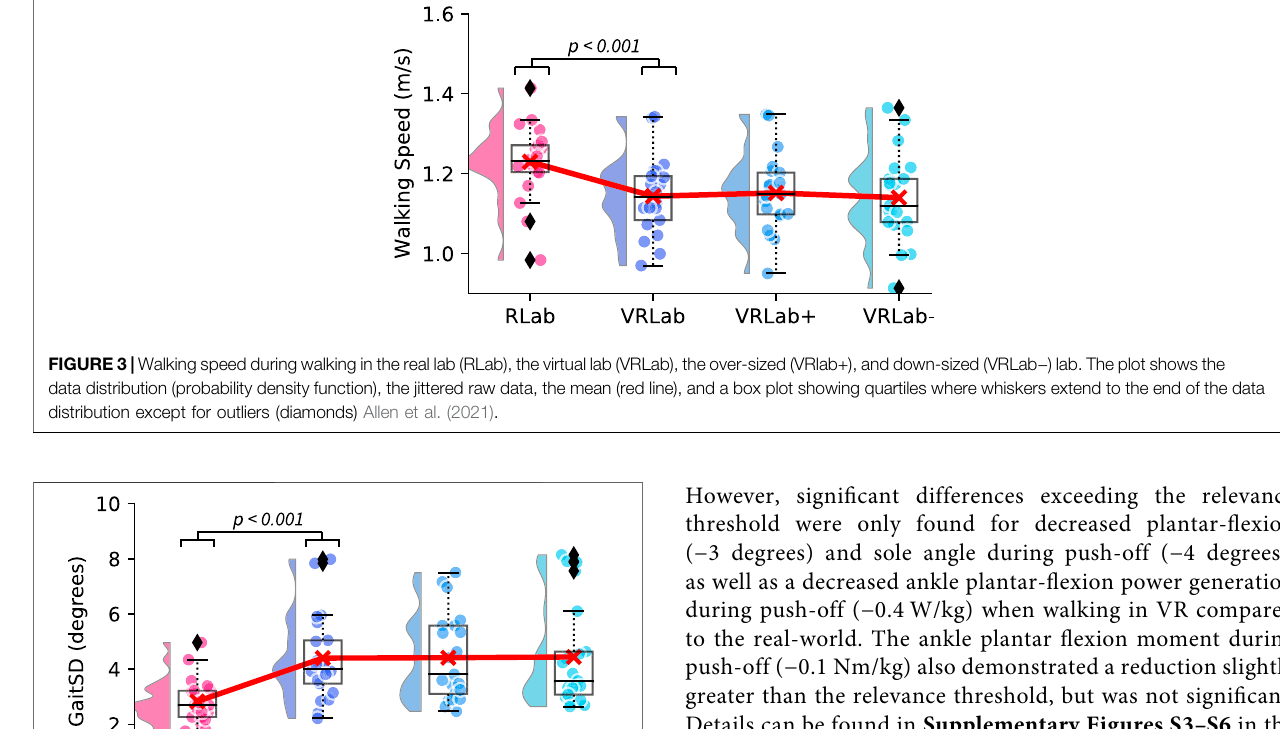
( Figure 4 ) from the RLab (2.8 ± 0.8) to the VRlab (4.4 ± 1.6), but no differences between VRlab+ (4.4 ± 1.6) and VRlab − (4.4 ± 1.9). SPM indicated some small but signi fi cant differences in lower and upper body kinematics, joint moments, and power.